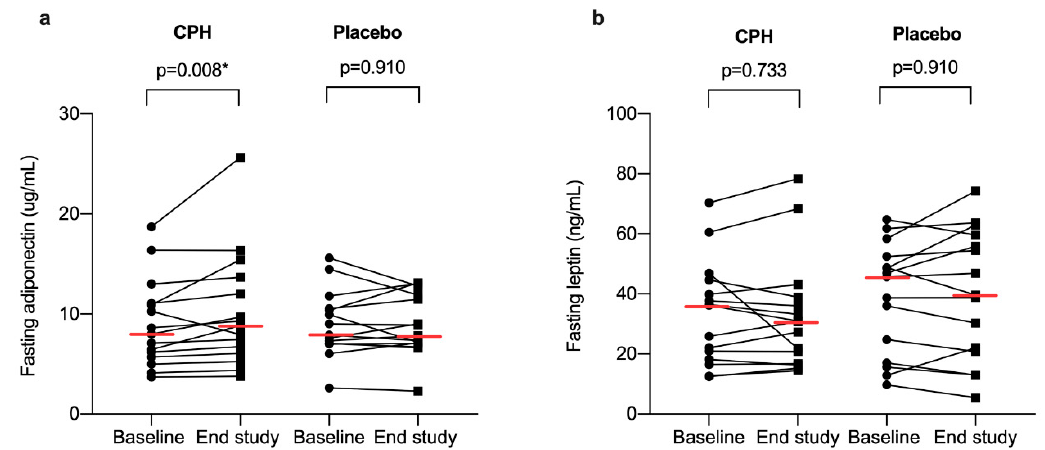
Figure 2. Fasting serum levels of adiponectin ( a ) and leptin ( b ) in participants with metabolic syndrome at baseline and after 8 weeks supplementation (end study) with cod protein hydrolysate (CPH) ( n = 15) or placebo ( n = 15). The red horizontal line shows the median levels. p -values within groups were calculated using the Wilcoxon’s Signed Rank Test. Statistically significant p -values are marked with an asterisk (*).